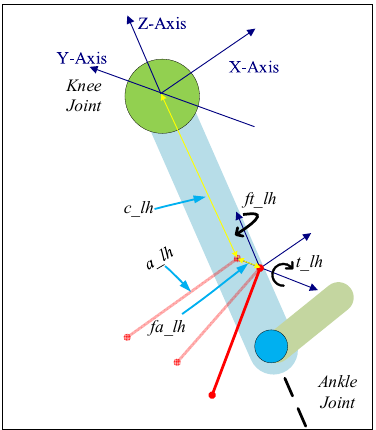
Figure 2. Generalized cuff definition using 5 parameters on Shank. Table 1. Generalized Cuff Parameters Definition.